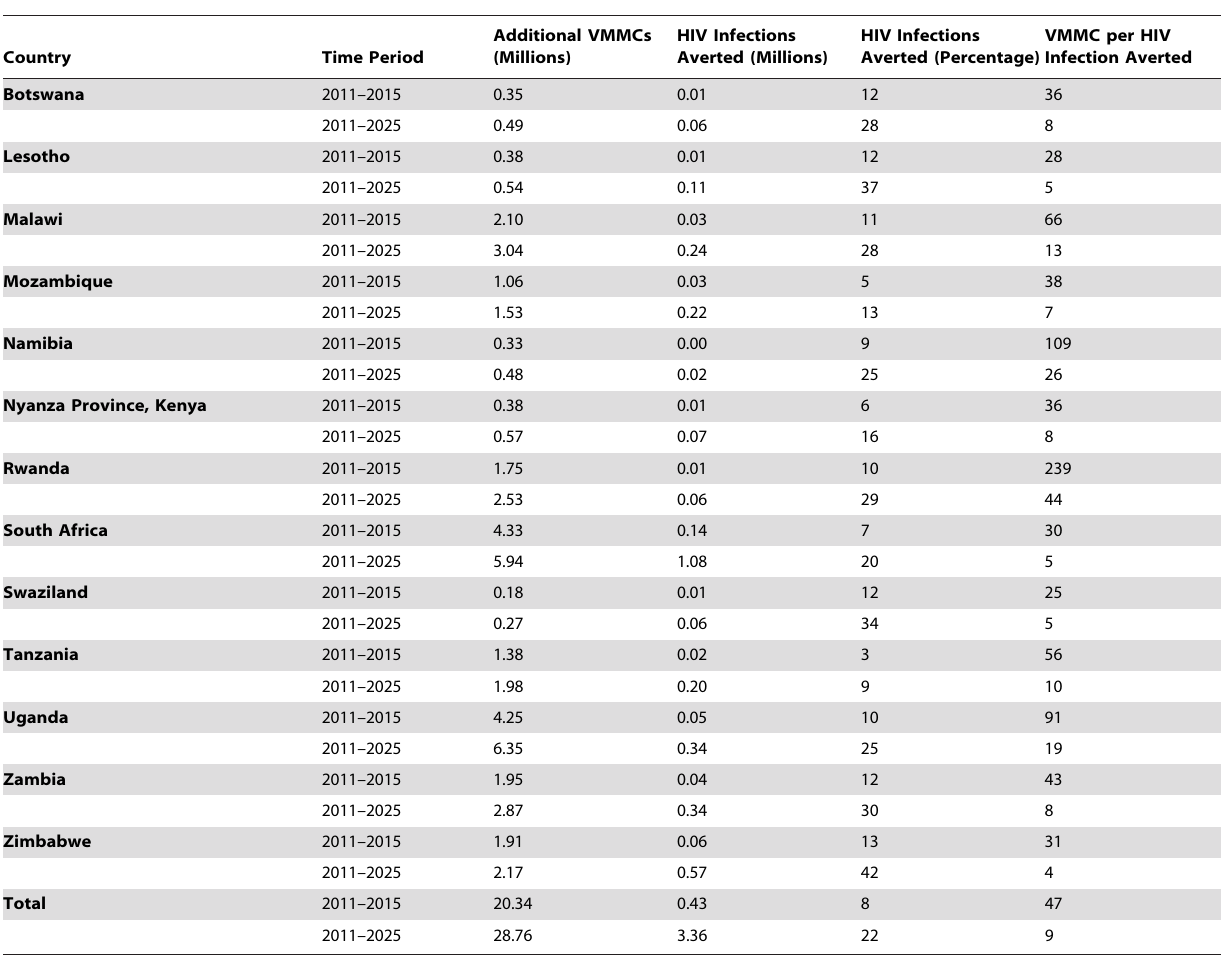
Table 4 presents the additional VMMCs and the impact of VMMC on HIV infections averted for 2011–2015 and 2011–2025 for the base case scenario. HIV infections averted are not